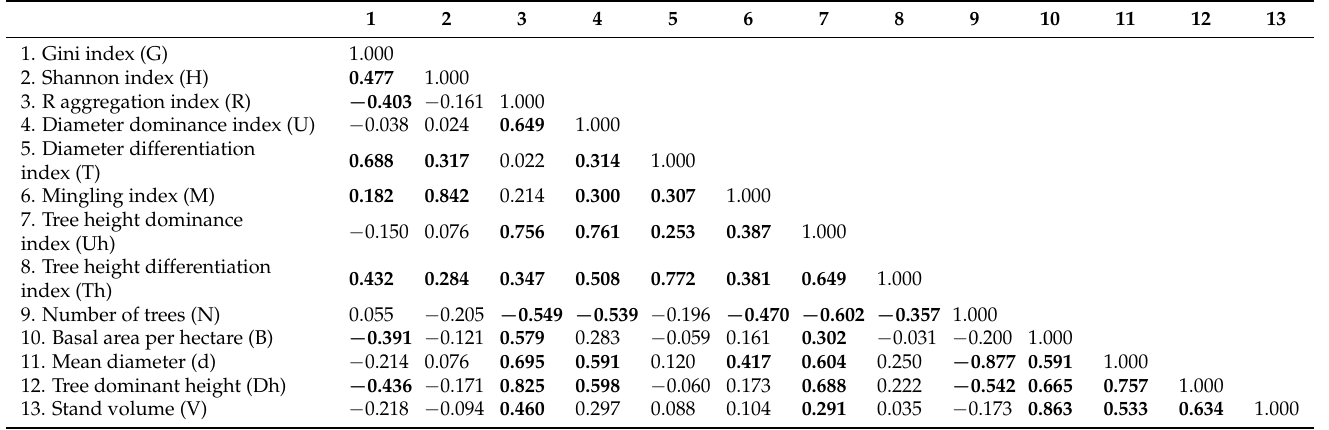
Table 4. Correlation coefficients (Spearman’s r ) between stand structural indices and stand structural parameters in the whole of the sampling plots. Associations that were statistically significant ( p < 0.05) are in